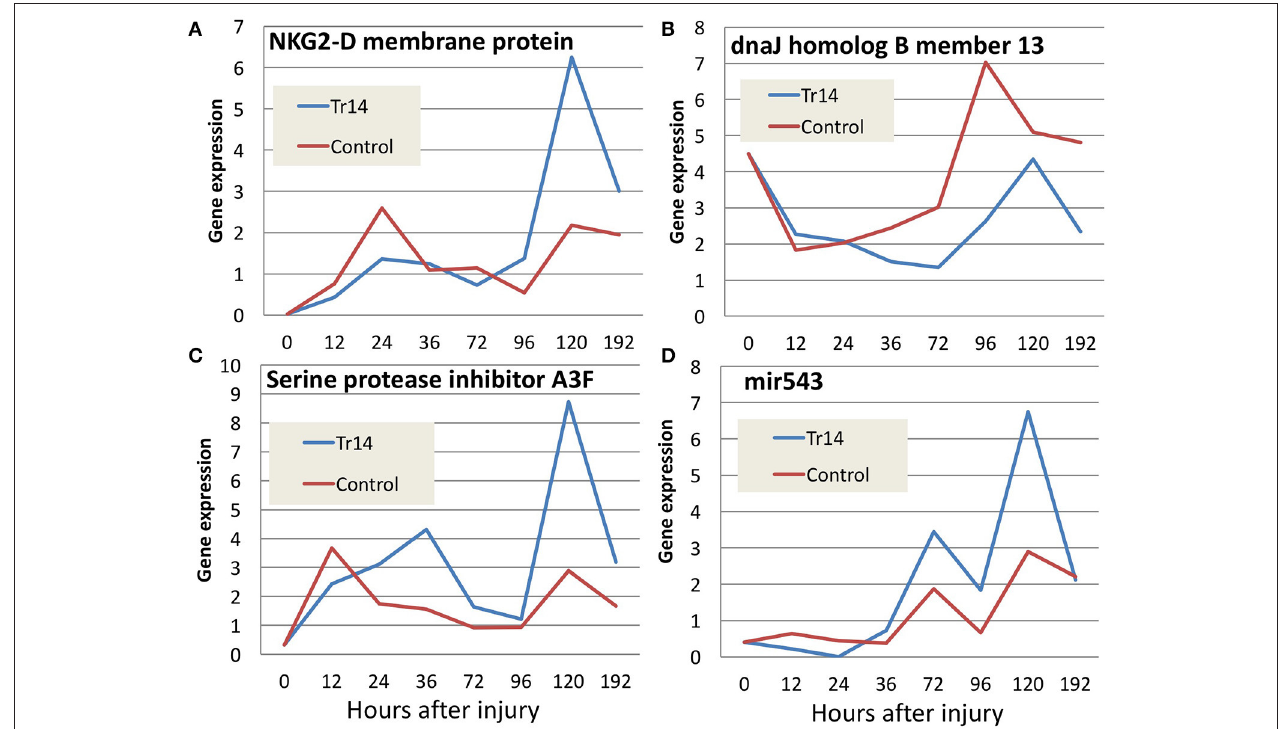
FIGURE 5 | Comparison of gene expression for selected transcripts (A–D) in Tr14 treated animals vs. saline controls. The X axis reports the time after injury to the mouse skin, when the wounded region was harvested for RNA and quantitation by RNA-seq. The Y axis reflects the average normalized gene expression for the transcripts specified in each panel. Red lines indicate expression levels in control mice and blue lines indicate levels in Tr14-treated wounds (IO